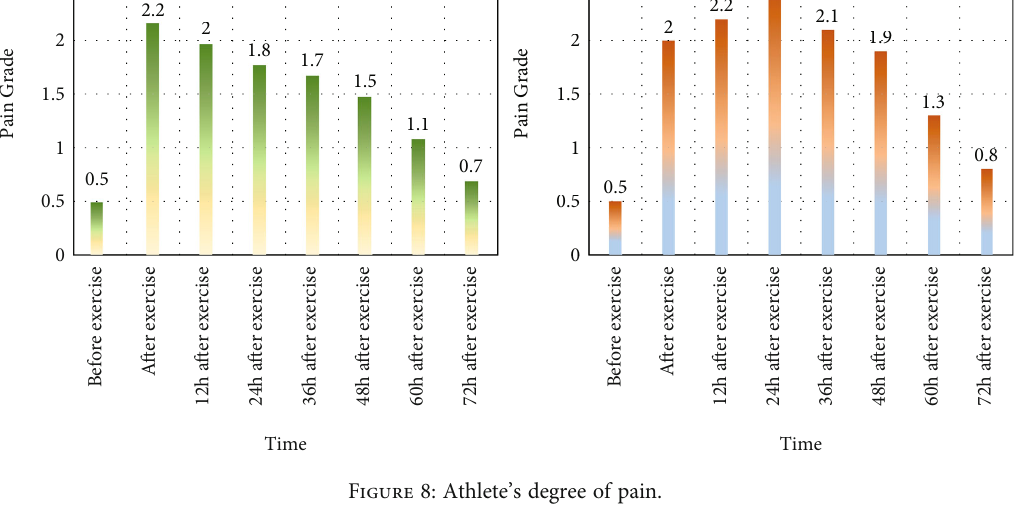
Figure 8: Athlete ’ s degree of pain.